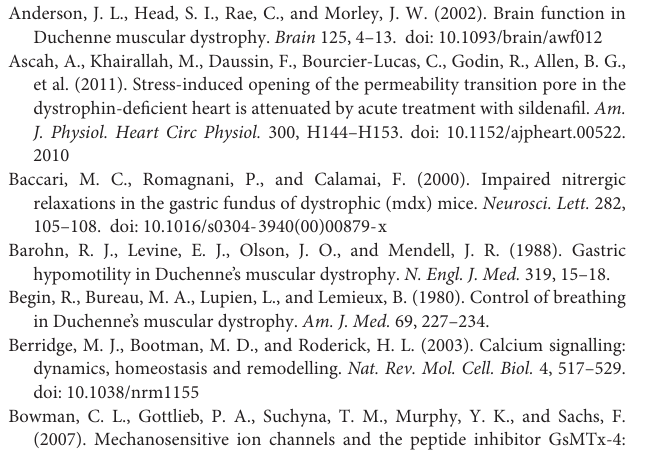
FIGURE S2 | Effects of removal of extracellular Ca2 + on the resting membrane potential. The omission of the Ca 2 + from the extracellular media induced a partial membrane depolarization (4–6 mV) in both genotypes. The reintroduction of Ca 2 + to the bathing media reverses the observed depolarization. For Vm: n mice = 3/experimental condition, n cell = 20–26/genotype. Values are expressed as means ± S.D. for each condition. Student’s t -test, *** p ≤ 0.001. FIGURE S3 | Stretching induced elevation of [Ca 2 + ] i in VSMCs is not inhibited by nifedipine. Exposure with nifedipine (NIFE) 10 µ M did not prevent the stretch (20% of resting length) induces elevation of [Ca 2 + ] i in VSMCs. For [Ca 2 + ] i : n mice = 3/experimental condition, n cell = 9–14/genotype. Values are expressed as means ± S.D. for each condition. Student’s t -test, *** p ≤ 0.001. FIGURE S4 | TRPC and Dystrophin protein levels in VSMCs. Each panel shows representative TRPC1, TRPC3, TRPC6 and Dystrophin protein expressions using corresponding fluorescent antibody. Data are presented as optical unit (OU) values normalized to Actin signal. Left Y axis shows MW sizes (kDa) of corresponding protein standard size markers. Right Y axis is labeled with name and size (kDa) of corresponding protein signal on the representative blot. Top X axis contains names of total protein extract samples loaded onto the representative